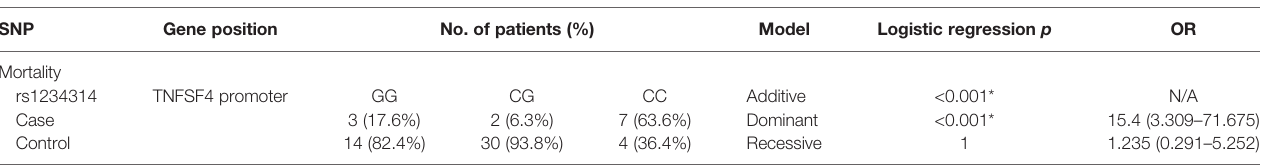
TABLE 5 | The SNPs in the TNFSF4 gene associated with the outcomes of post-CBT. SNP